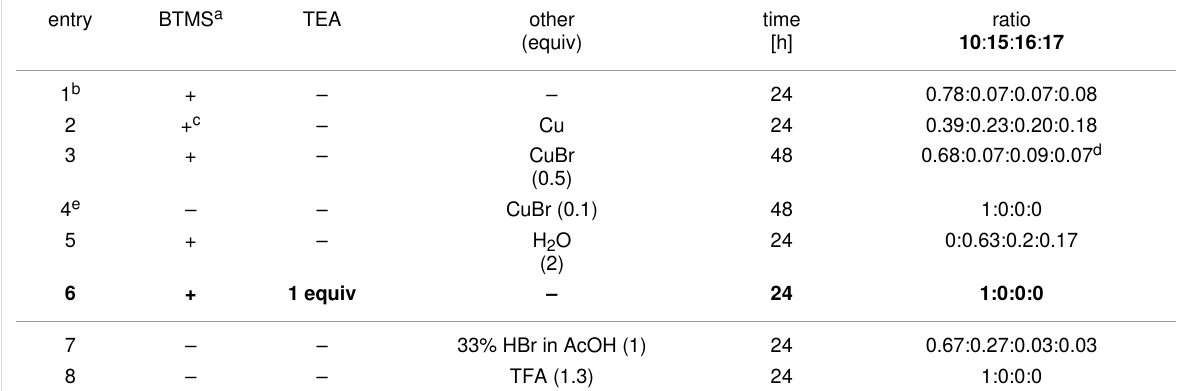
Table 1: Investigation of the reaction between propargylamide 10 and